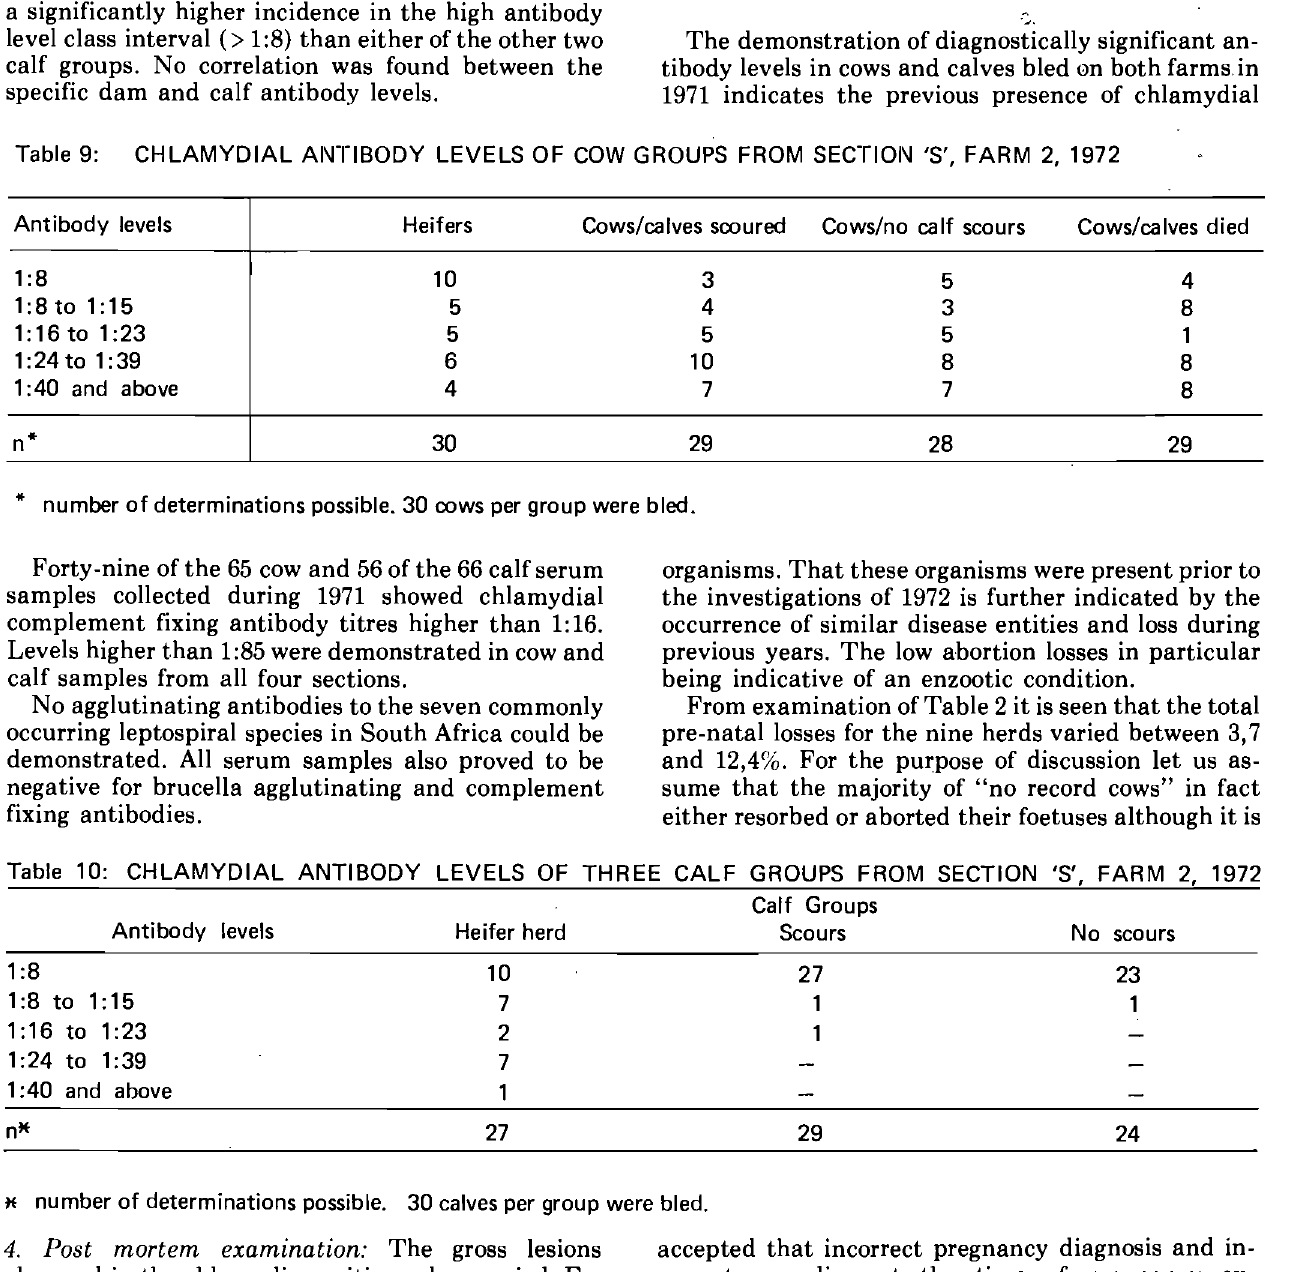
CHLAMYDIAL ANTIBODY LEVELS OF COW GROUPS FROM SECTION'S', FARM 2, 1972 Antibody levels Heifers Cows/calves scoured Cows/no calf scours Cows/calves died